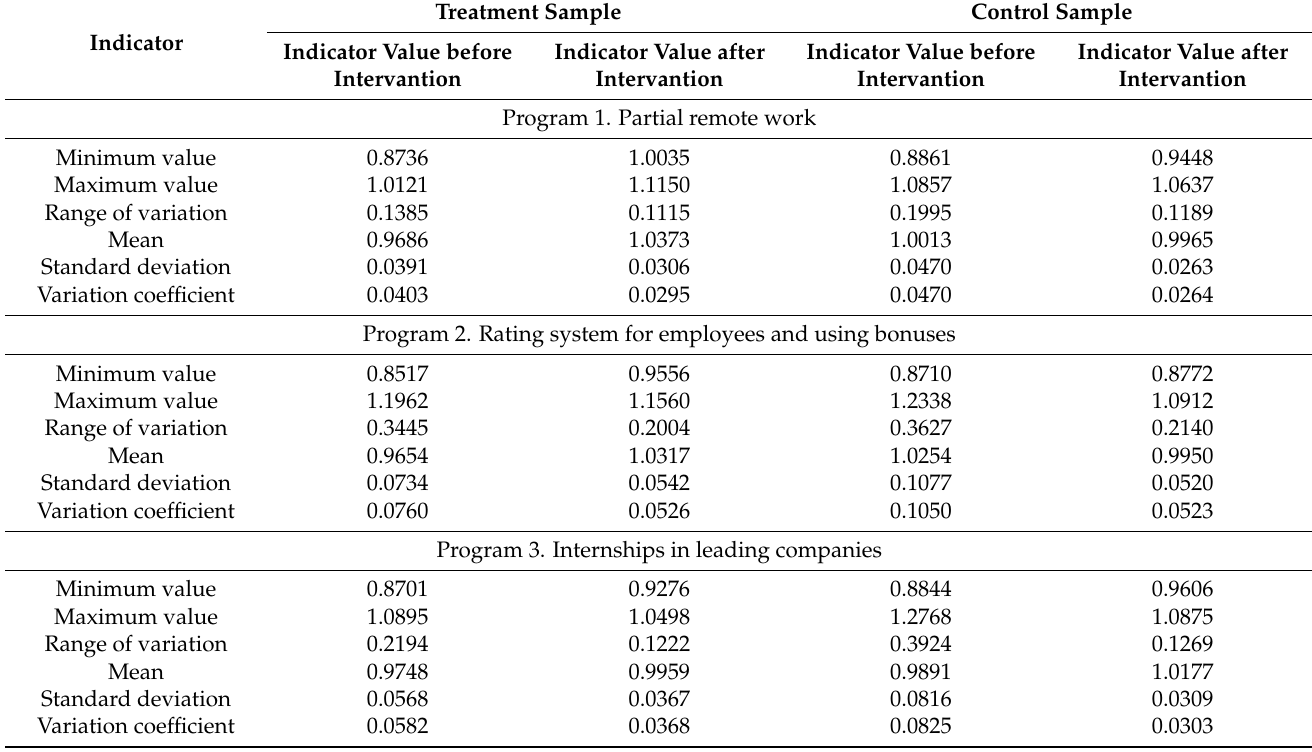
Table 2. Descriptive statistics for the labor productivity growth rates (%) by the programs